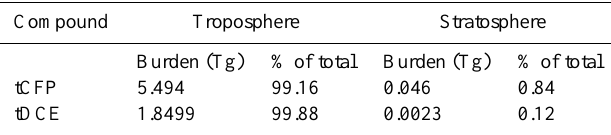
Table 2. Burdens of tCFP and tDCE calculated in MOZART 3 tro- posphere and stratosphere for 50.0Tgyear − 1 surface flux of each compound.